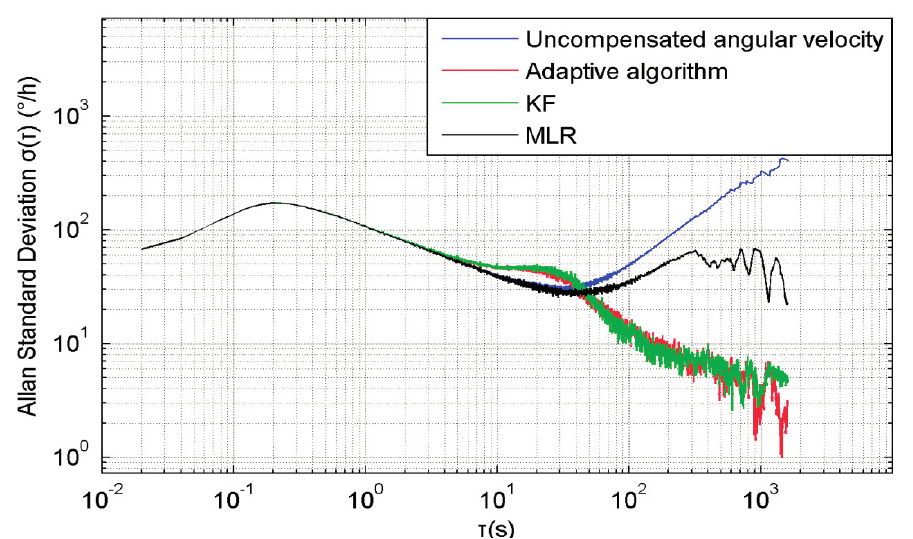
Figure 6. Allan standard deviation of uncompensated and compensated angular